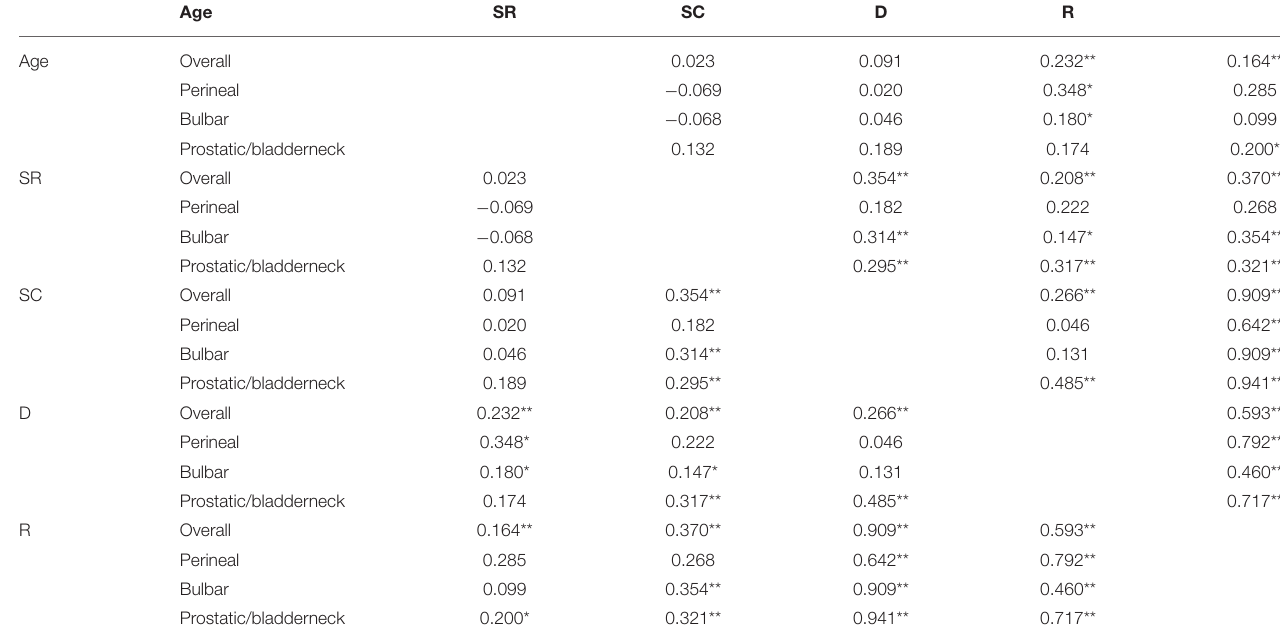
TABLE 3 | Correlation of age, SR, SC, D, and R. Age